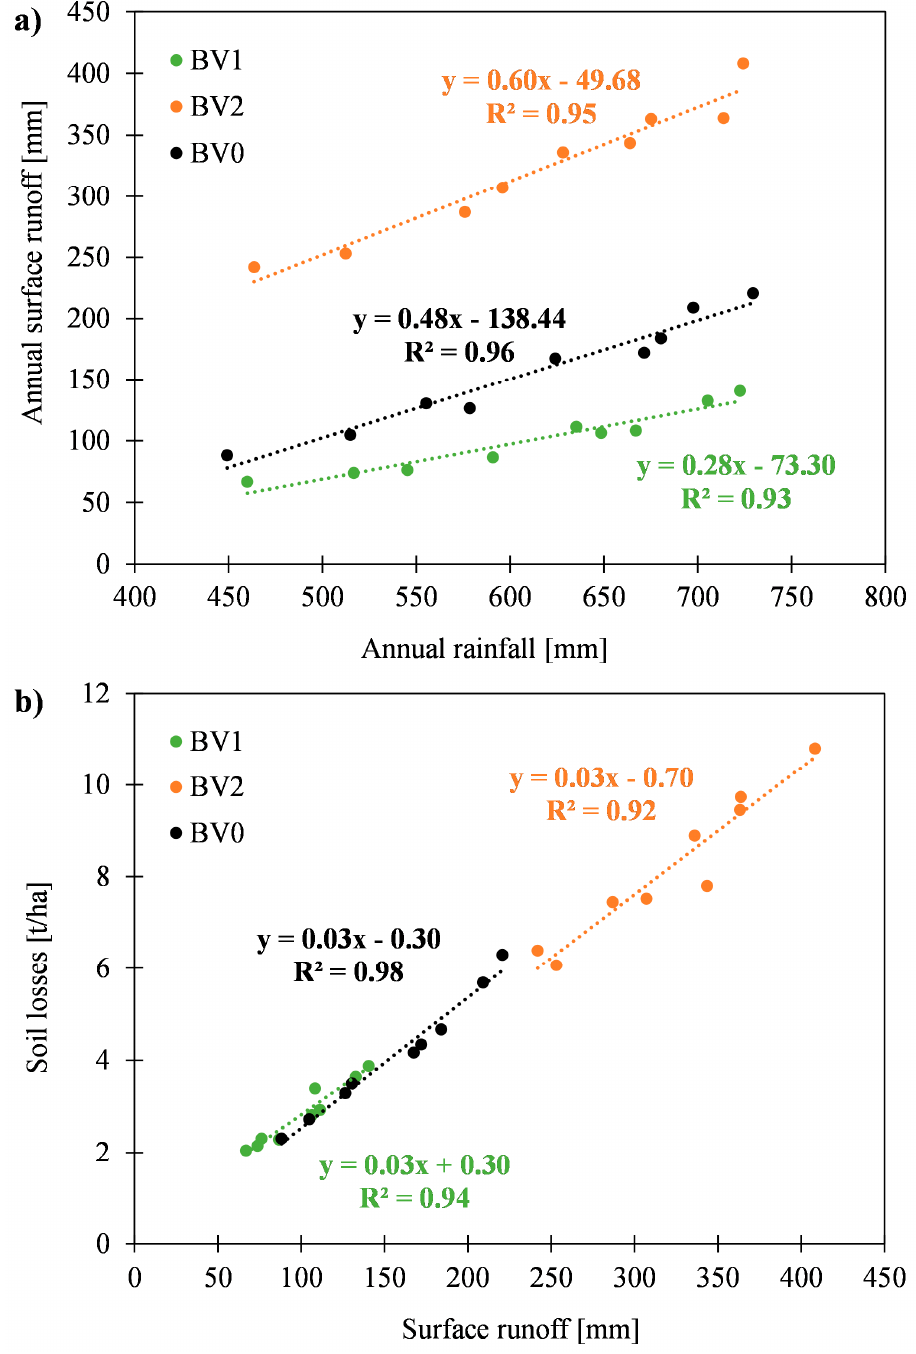
Figure 3. Relationship between annual rainfall, surface runoff and soil loss rates in Tougou watershed. ( a ) Linear relationship between annual rainfall and surface runoff. ( b ) Linear relationship between surface runoff and soil losses. BV1 is the cultivated sub-watershed, BV2 is the bare and degraded sub-watershed and BV0 is the Tougou watershed.